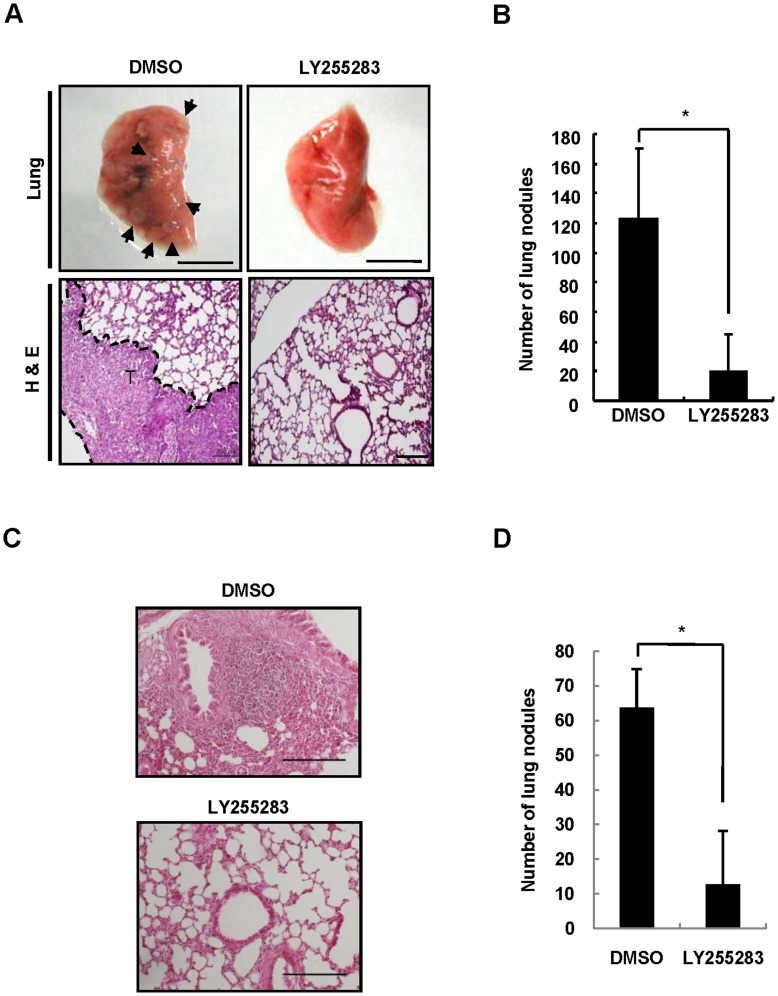
BLT2 inhibition suppresses metastasis of MDA-MB-231 cells in vivo.(A and B) MDA-MB-231 cells treated for 24 h with LY255283 (10 µM) or DMSO were injected into the tail vein of nude mice, which were subsequently injected intraperitoneally with DMSO (control) or LY255283 (2.5 mg/kg) at 3 and 5 days after cell injection. Mice were killed 10 weeks after cell injection, and the lungs were removed and subjected to histological analysis (A). Arrowheads indicate metastatic nodules. Scale bars, 5 mm (upper panels) and 200 µm (lower panels). The number of metastatic nodules in the lungs was also counted (B); data are means±SD of values from four mice of each group. *P<0.05. (C and D) MDA-MB-231 cells pretreated for 24 h with LY255283 (10 µM) or DMSO were implanted into the mammary fat pad of nude mice, and the animals were then injected intraperitoneally with LY255283 (2.5 mg/kg) or DMSO (control) three times at 5-day intervals. The mice were killed 14 weeks after cell implantation, and lung sections were stained with H&E for analysis of metastatic nodules (C). Scale bars, 200 µm. The number of metastatic nodules in the lung was also counted (D). Data are representative of results obtained with three mice per group. *P<0.05.